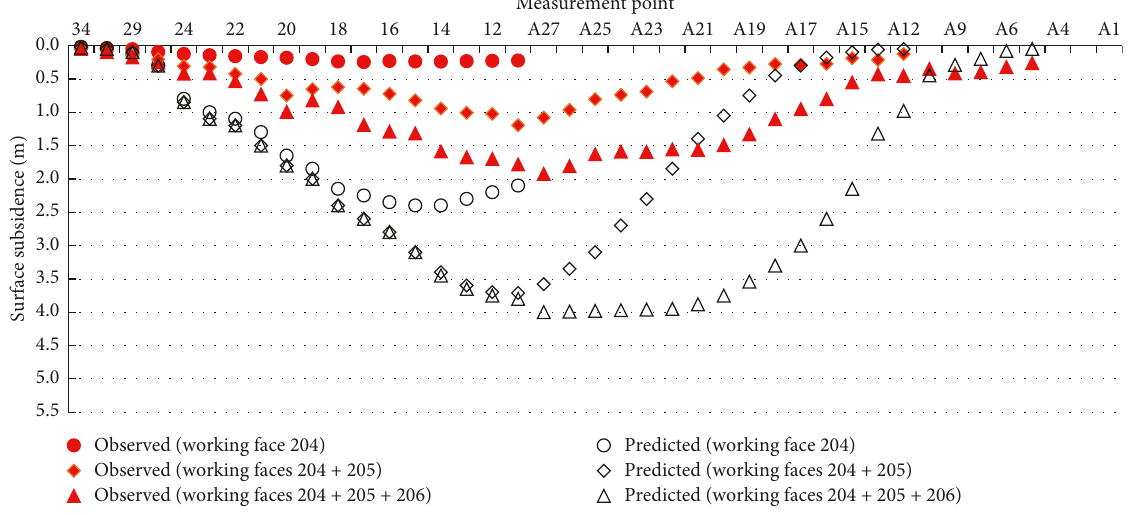
Figure 3: Comparison between the measured subsidence value and the predicted subsidence value by the probability integral method at the surface subsidence measurement point (measurement point no.